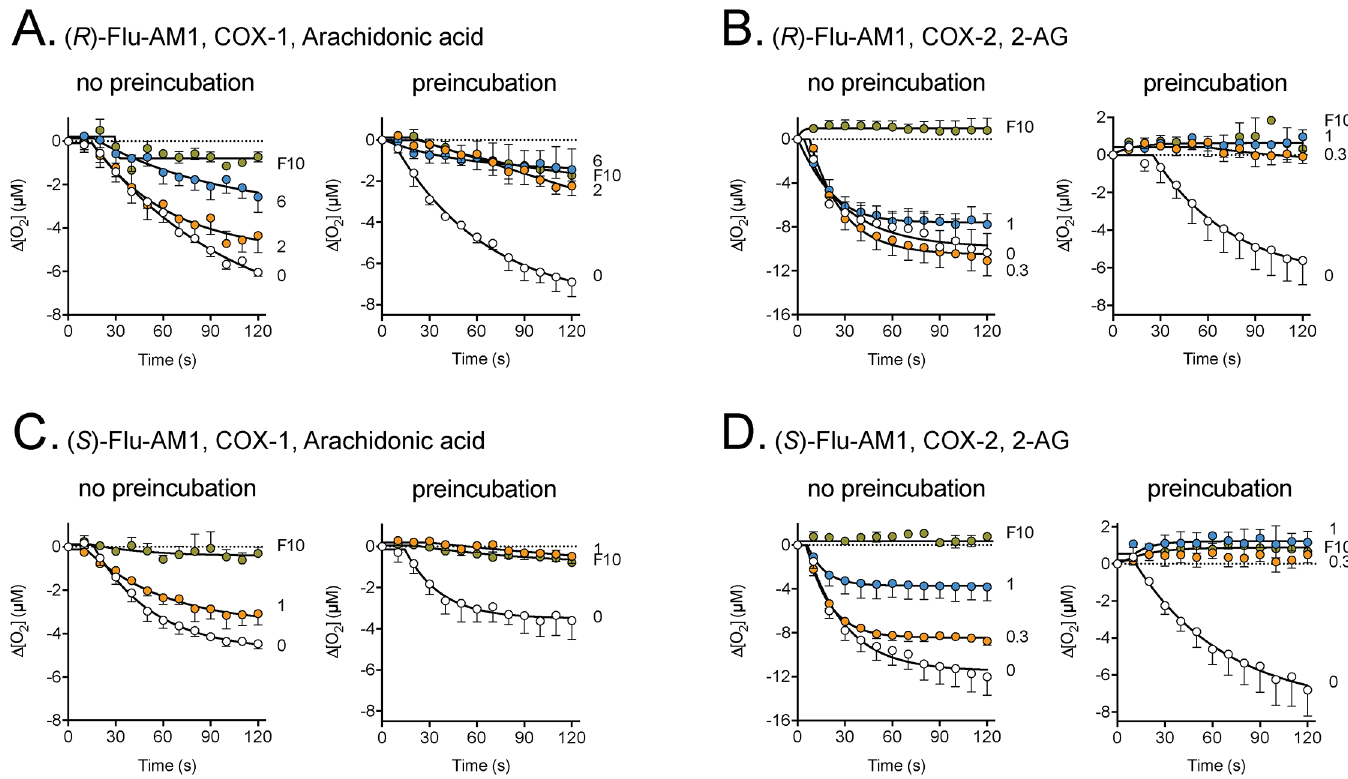
Fig 2. Effect of a preincubation phase on the inhibition of COX by the enantiomers of Flu-AM1. The concentrations, in μ M, of the inhibitors are shown on the right of each panel (F10 refers to 10 μ M racemic flurbiprofen, used as a positive control). The Flu-AM enantiomer, enzyme isoform and substrate (10 μ M concentration) used is shown above each panel. The preincubation time was 5 min. Shown are means ± s.e.m., n = 3, except for the flurbiprofen curves in the no preincubation conditions in panels A and D, where n = 2.